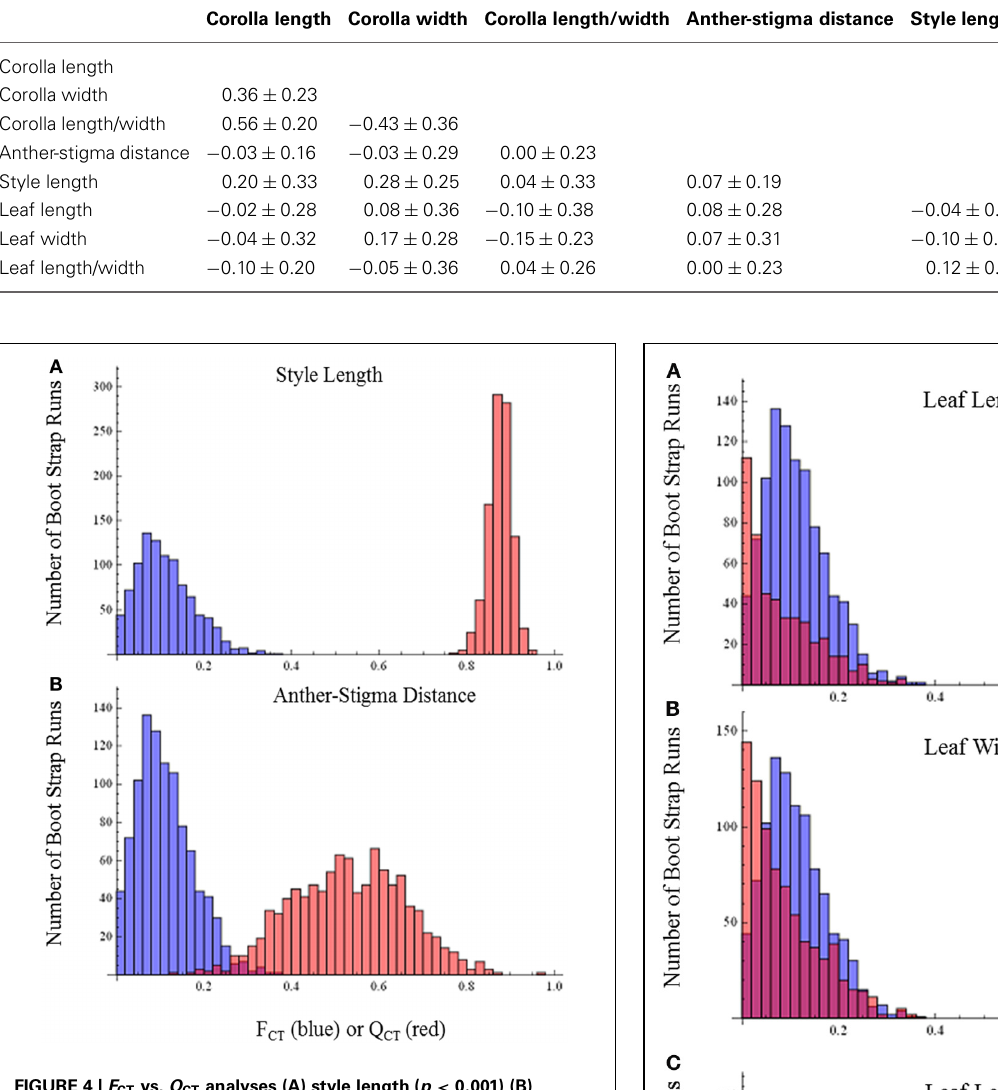
FIGURE 4 | F CT vs. Q CT analyses (A) style length ( p < 0 . 001) (B) anther-stigma distance ( p = 0 . 002). it appears to be explainable by variation in floral morphology.